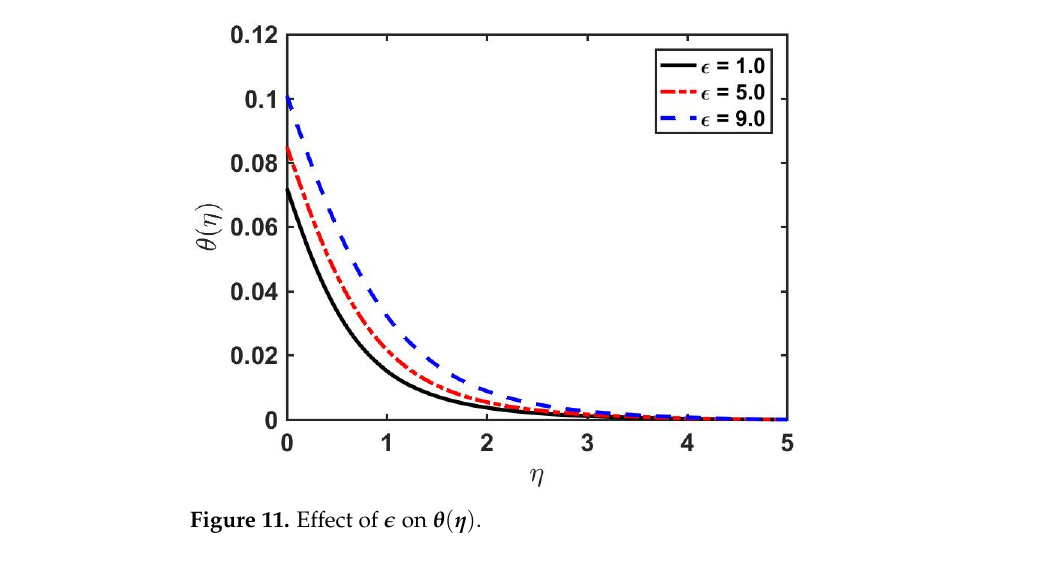
Figure 10. Effect of 𝑬𝒄 on 𝜽(𝜼) .